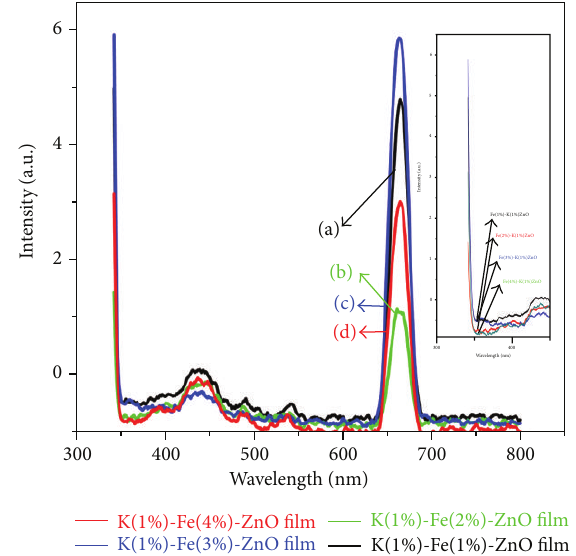
Figure 10: Photoluminescence spectrum of (K (1%), Fe) codoped ZnO for Fe concentrations: (a) 1%, (b) 2%, (c) 3%, and (d) 4%.